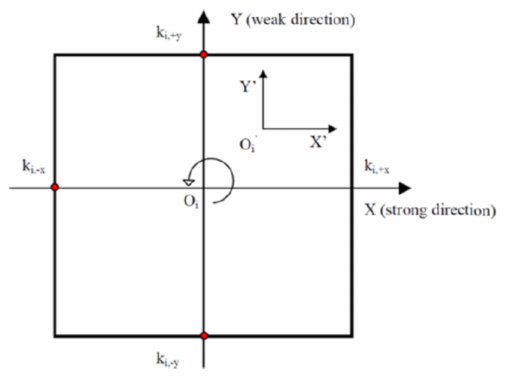
Figure 6. Floor Plan for Benchmark